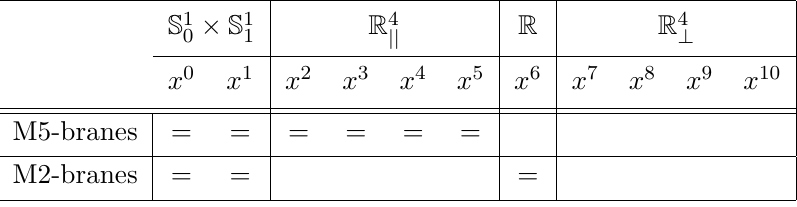
Table 1 . Non-compact BPS con(cid:12)guration of M5- and